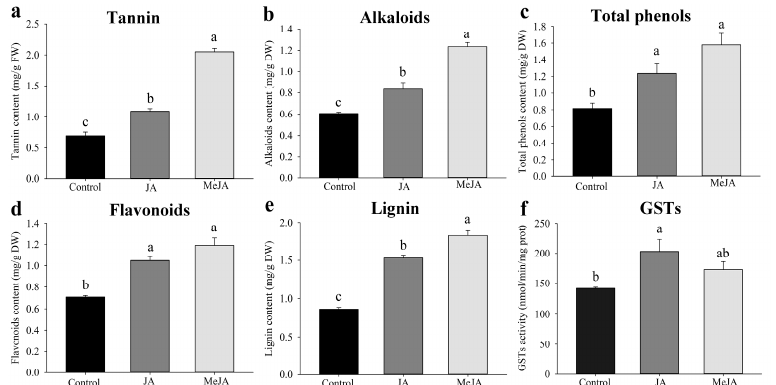
Figure 3. Jasmonic acid (JA) and methyl jasmonate (MeJA) induce secondary metabolite accumulation in kidney bean leaves and activate glutathione S-transferase (GST) activity in second-instar larvae of Frankliniella occidentalis . ( a – e ) are contents of tannins, alkaloids, total phenols, flavonoids, and lignin, respectively, in kidney bean leaves. ( f ) GST activity in second-instar larvae. Values are the mean ± SE. Different lowercase letters indicate significant deference among all treatments ( p < 0.05; one-way ANOVA, followed by Tukey’s test). The effects of JA-induced kidney bean leaf defensive metabolites on activity and gene mRNA levels of thrips GSTs were further characterized. An Ultra High-Performance Liq- uid Chromatography AB Triple TOF 6600 mass spectrometer system (UHPLC-Q-TOF MS) was used to detect differential metabolites in JA-induced and control kidney bean leaves. Orthogonal partial least-squares discriminant analysis (OPLS-DA) indicated that the JA and control groups were completely separated in the positive and negative ion modes, and metabolic profiles were different, with all samples within the 95% confidence interval. This result indicated that the metabolites detected in the JA and control groups were sig- nificantly different (Figure 4). To evaluate the model, parameters were obtained by seven- fold cross-validation, including R 2 Y > 0.99 and Q 2 > 0.5 (Tables S1 and S2). Thus, the data model was stable and reliable. Figure 4. Orthogonal partial least squares discriminant analysis (OPLS-DA) score plot of jasmonic acid-treated and control samples. ( a ) Positive ion mode (Pos); ( b ) negative ion mode (Neg). The abscissa t[1] represents principal component 1, the ordinate t[1] represents principal component 2, and the ellipse represents the 95% confidence interval. Dots of the same color represent each